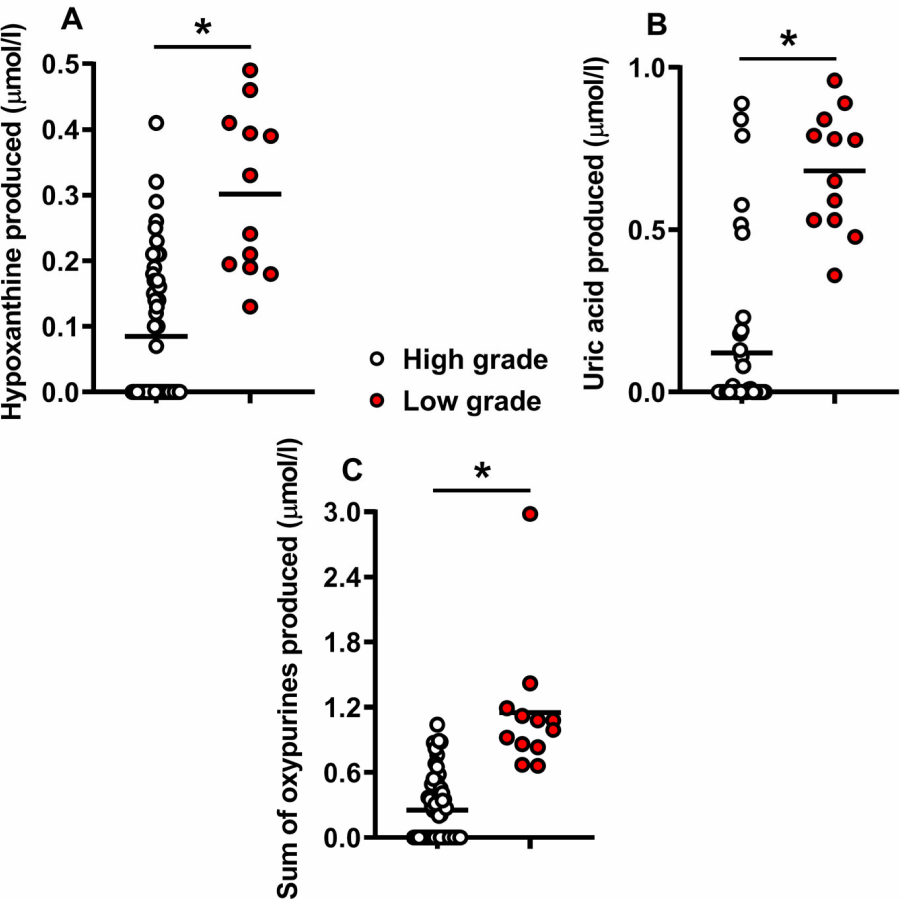
Figure 1. Concentrations of hypoxanthine ( A ), uric acid ( B ), and the sum of oxypurines ( C ) detected in culture media of human embryos at 5 days post-fertilization. The two groups of high-grade (n = 54, empty circles) and low-grade (n = 12, red filled circles) embryos were morphologically classified according to the Gardner scale. The mean values are represented by the horizontal bars. Sum oxypurines = hypoxanthine + uric acid. * Significantly different from high grade, q < 0.0001 ( A – C